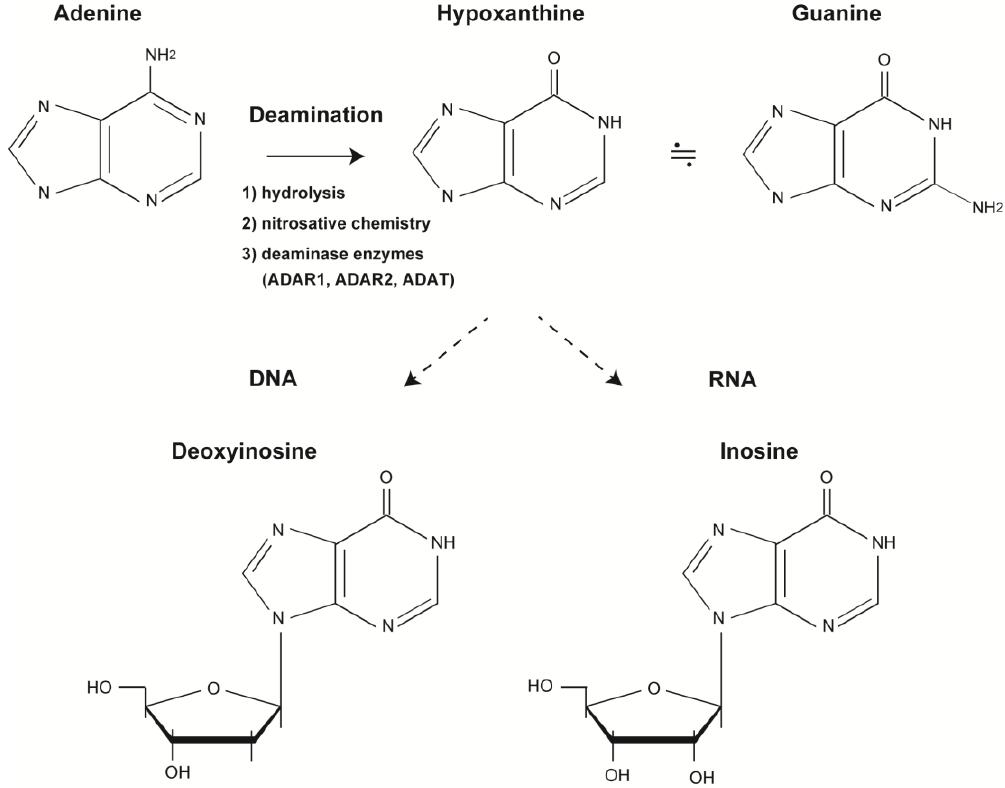
Figure 1. Formation of deoxyinosine and inosine. Deamination of adenine to